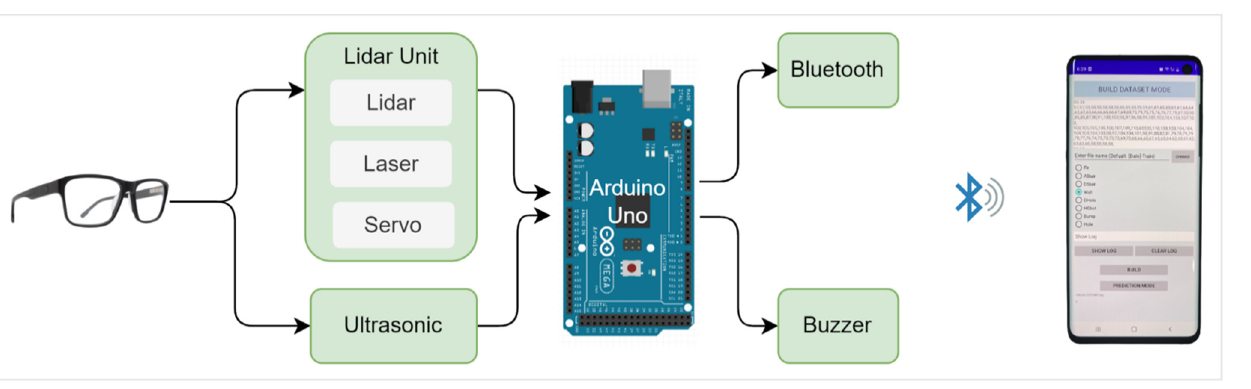
Figure 6. System